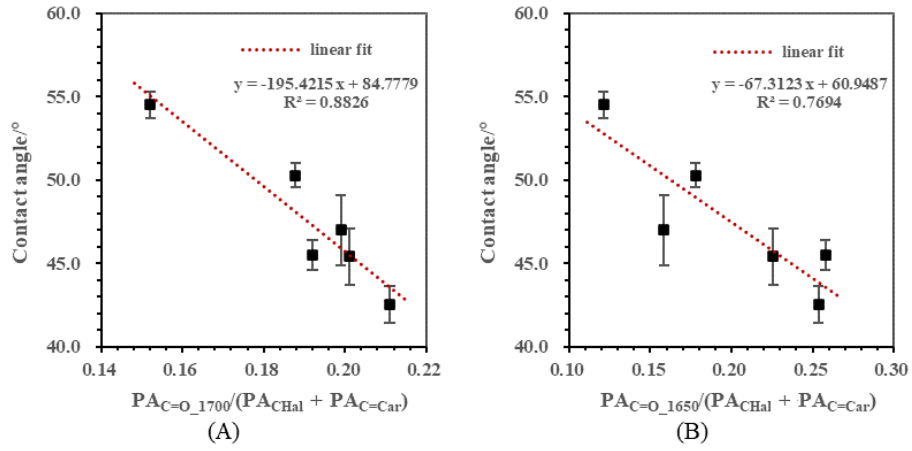
Figure 6. Correlations between contact angles and carbonyl semi-quantitative ratios. ( A ) Correlation between contact angle and PA C=O_1700 /(PA CHal + PA C=Car ); ( B ) Correlation between contact angle and PA C=O_1650 /(PA CHal + PA C=Car ).